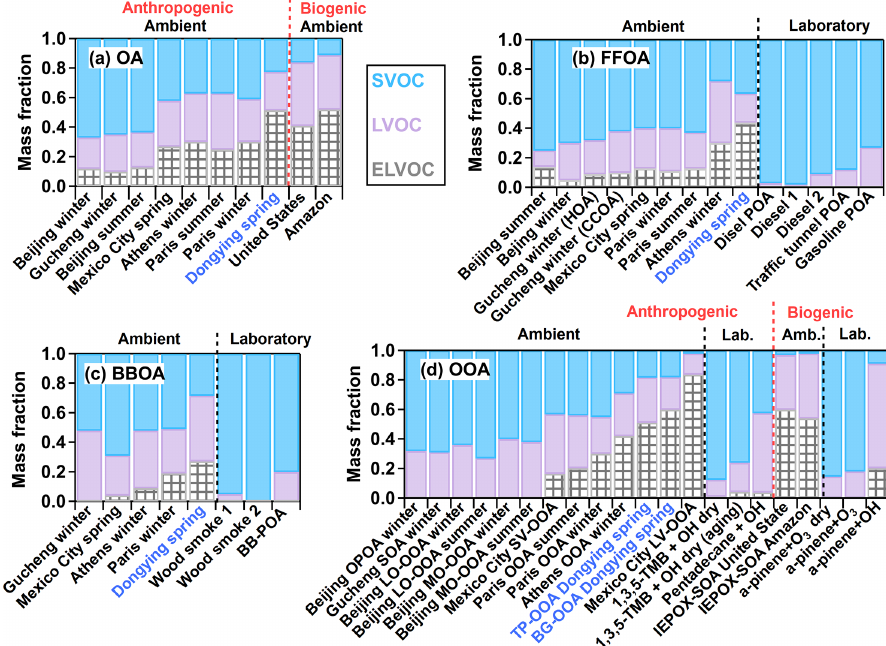
Figure 9. Fractional contributions of different volatile species to (a) total OA, (b) fossil fuel-related OA (FFOA, which represents a sum of coal combustion OA (CCOA) and HOA), (c) BBOA, and (d) OOA in different studies. These studies includes Dongying (this study), Beijing and Gucheng (Xu et al., 2021), Paris (Paciga et al., 2016), Athens (Louvaris et al., 2017b), Mexico City (Cappa and Jimenez, 2010), southeastern United States and the Amazon (Hu et al., 2016c), and several laboratory experiments (Grieshop et al., 2009b, c; X. Li et al., 2016; May et al., 2013a, b, c; Sato et al., 2018, 2019; Ylisirniö et al., 2020). Detailed data can be found in Tables S2–S5. In panel (d) LO-OOA, MO-OOA, SV-OOA, and LV-OOA represent less oxidized OOA, more oxidized OOA, semivolatile OOA, and low volatile OOA, respectively. TP-OOA and BG-OOA represent transported- OOA and background-OOA resolved in this study. TMB and IEPOX-SOA represent trimethylbenzene and isoprene-epoxydiols-derived secondary OA, respectively. Lab. and Amb. represent studies from laboratories and field measurements of ambient